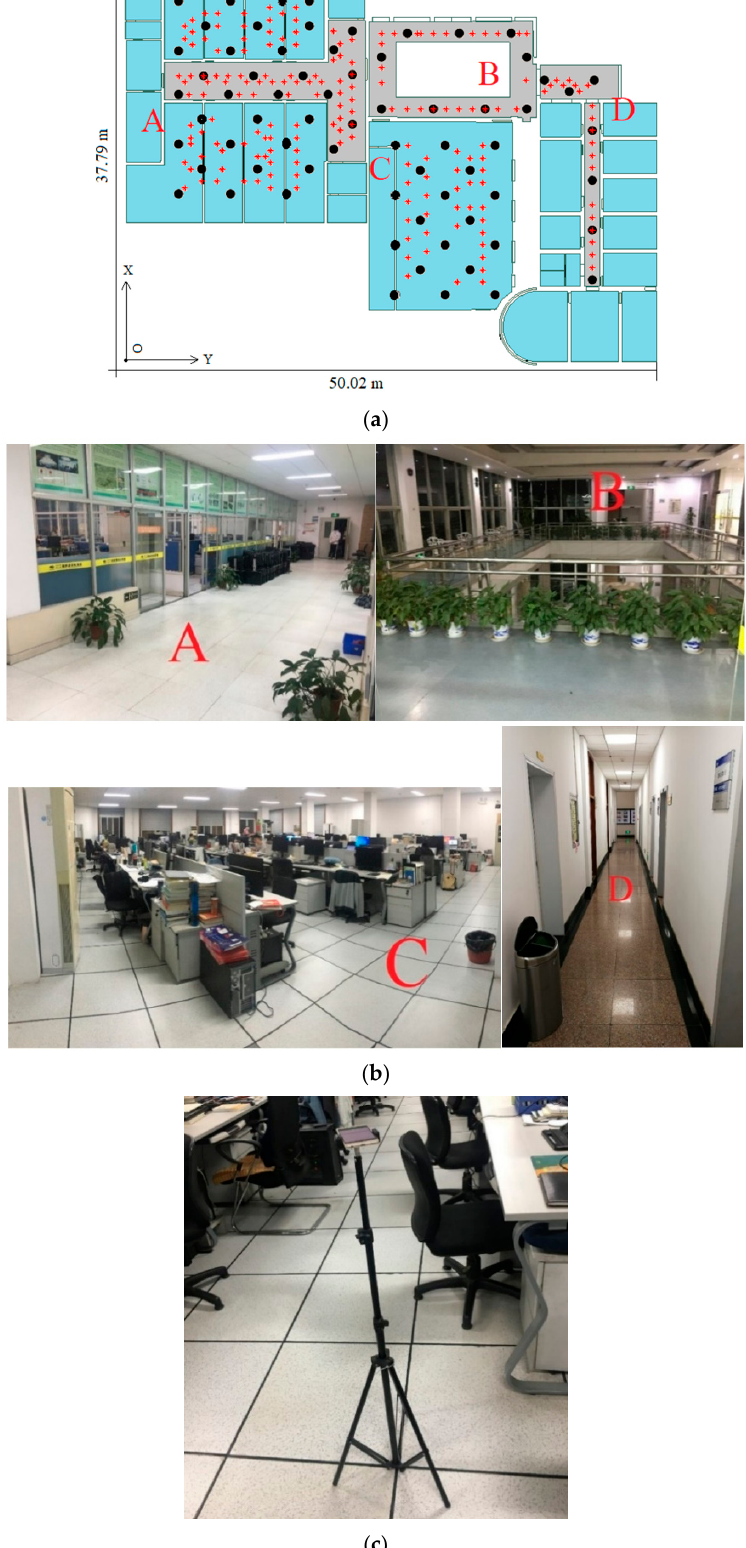
Figure 3. Schematic diagram of the experimental environment. ( a ) The distribution of reference points (black dots) and test points (red dots); ( b ) the corresponding real experimental environments; ( c ) the placement of the